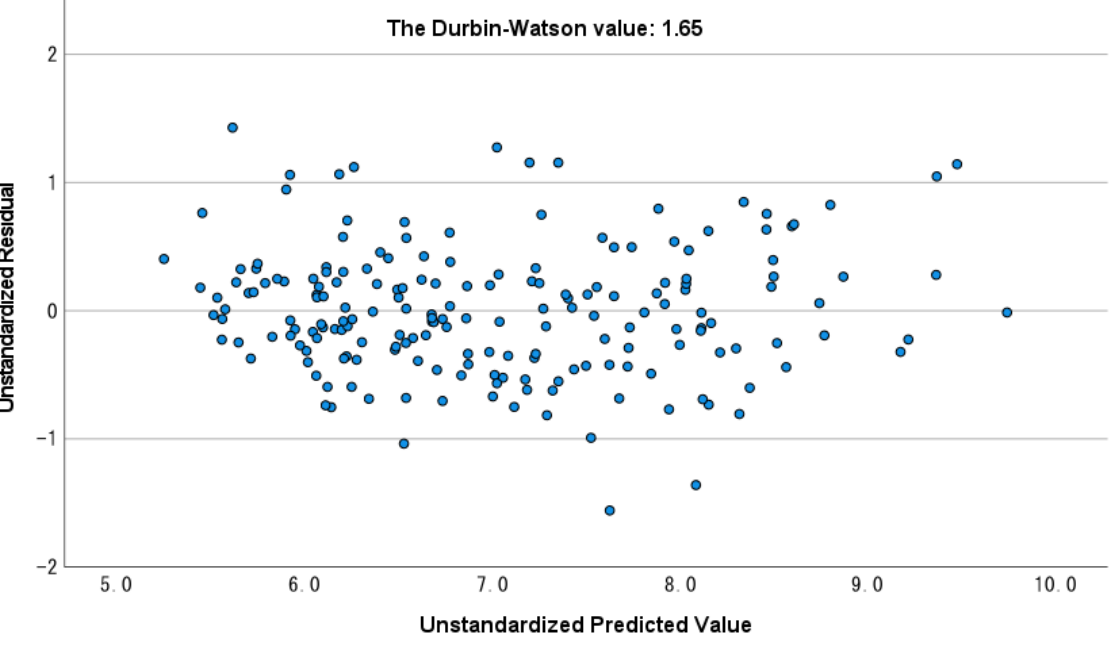
Figure 2. The residual plot and Durbin–Watson value for the dependent variable in stepwise multiple regression analysis.